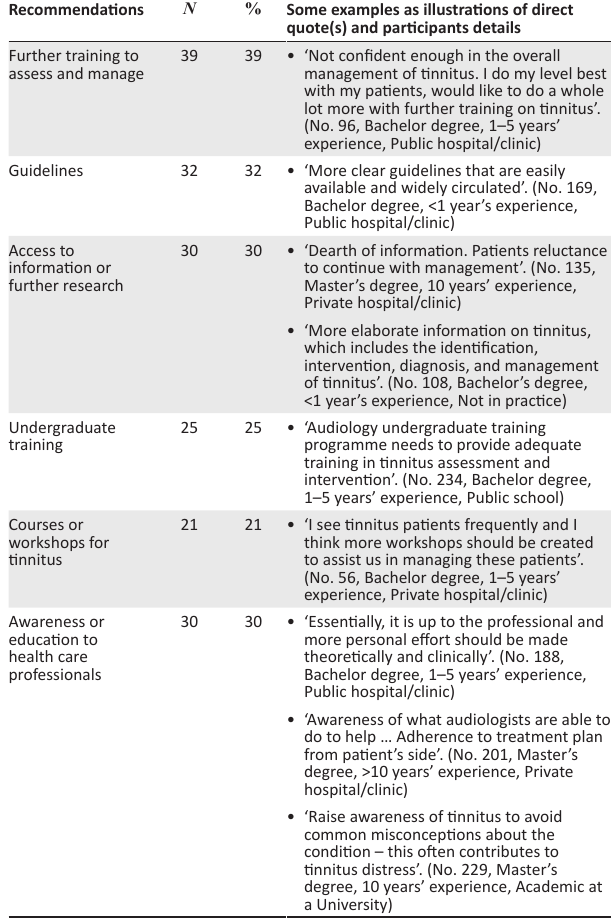
TABLE 7: Techniques used by participants as part of their intervention with tinnitus patients. Techniques used for tinnitus intervention